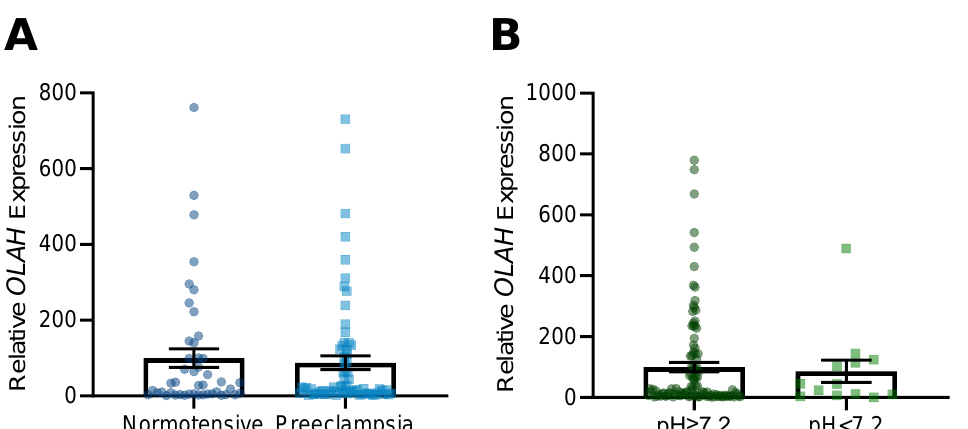
Figure 1. OLAH mRNA transcripts in the maternal circulation of pregnancies complicated by fetal growth restriction with or without preeclampsia or fetal acidemia. Transcript levels were measured via qPCR. OLAH transcripts were not significantly altered in the circulation of cases of preeclampsia with fetal growth restriction, compared to normotensive cases of fetal growth restriction ( A ). Cases of growth restriction where the fetus was delivered with umbilical cord artery pH < 7.2 did not have significantly altered OLAH transcripts in the maternal circulation compared to those with pH ≥ 7.2 ( B ). Data presented as relative expression, mean ± SEM. Normotensive n = 44, preeclampsia n = 71, case pH ≥ 7.2 n = 107, case pH < 7.2 n = 18.